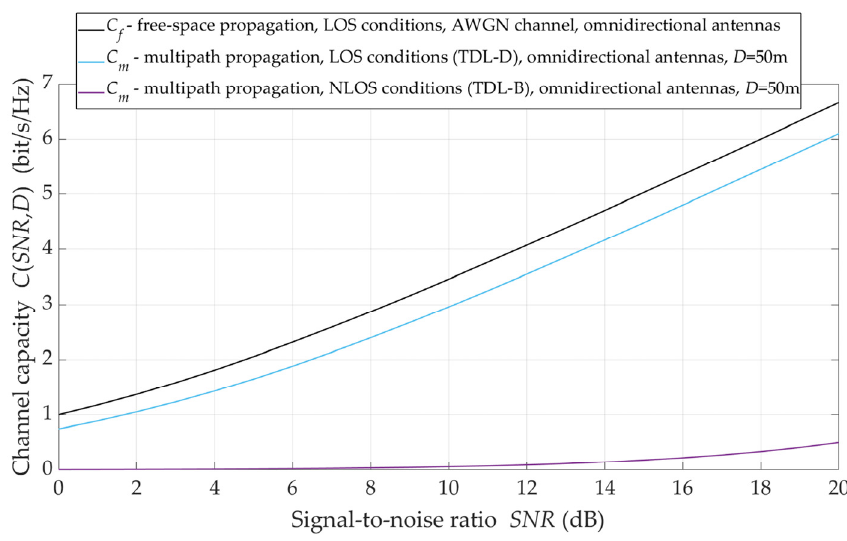
Figure 10. Capacity versus SNR for omnidirectional antenna pattern and different propagation con- ditions.